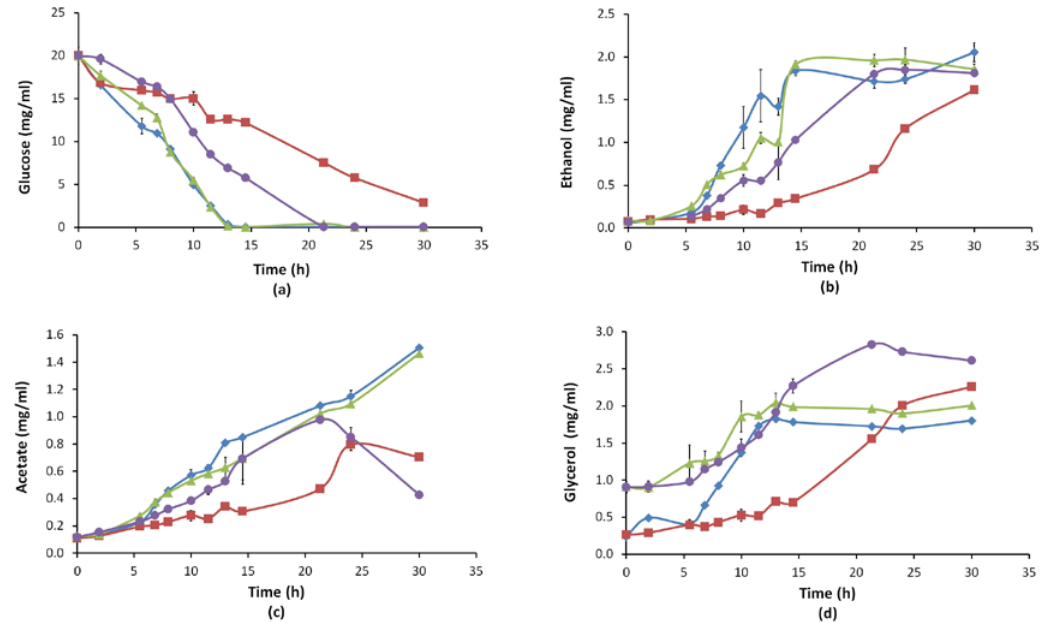
Figure 4. Average glucose ( a ), ethanol ( b ), acetate ( c ) and glycerol ( d ) concentrations (mg/mL) of 905 and M8FE in the absence and presence of iron stress ( (cid:95) 905 under control condition, (cid:4) 905 under iron stress condition, (cid:78) M8FE under control condition, (cid:8) M8FE under iron stress condition).